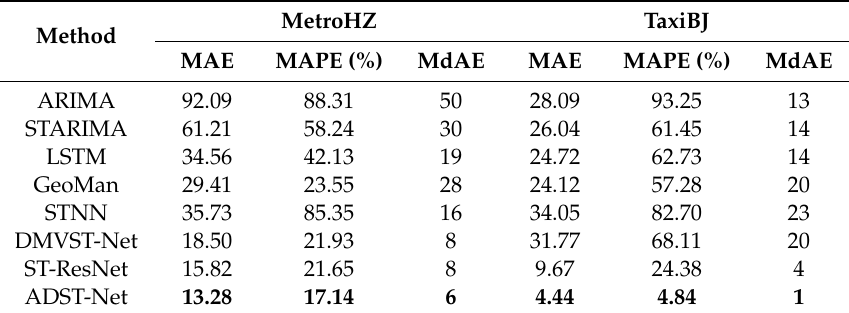
Table 5. Prediction Performance Comparison on Two Public datasets.